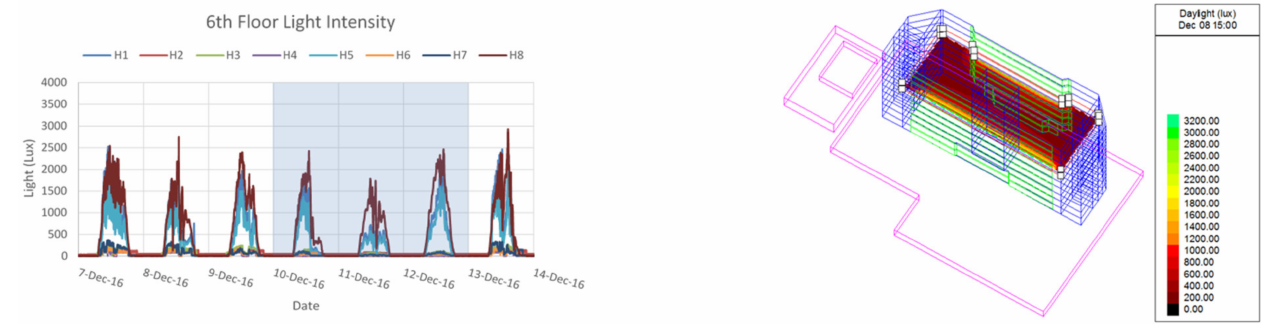
Figure 8. Readings of illuminance levels for 7 days in level 6 (field measurements on the left and simulation results on the right )